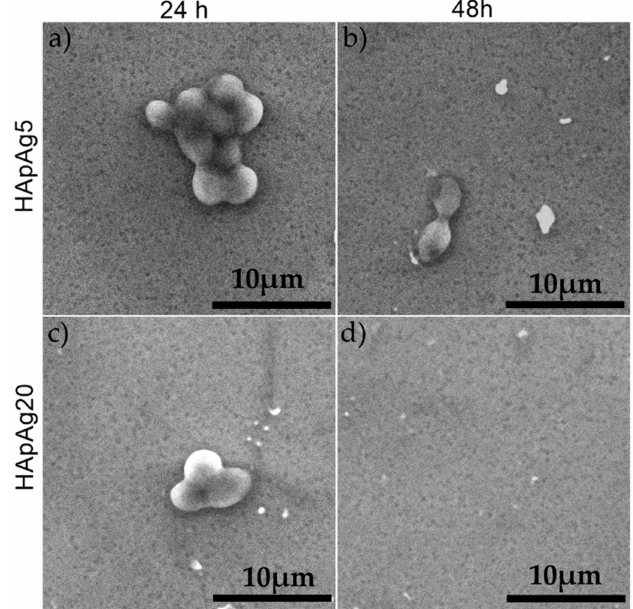
Figure 8. SEM images of Candida albicans ATCC 10231 cell development on HApAg5 composite layers after 24 and 48 h ( a , b ) and SEM images of Candida albicans ATCC 10231 cell development on HApAg20 composite layers after 24 and 48 h of incubation ( c , d